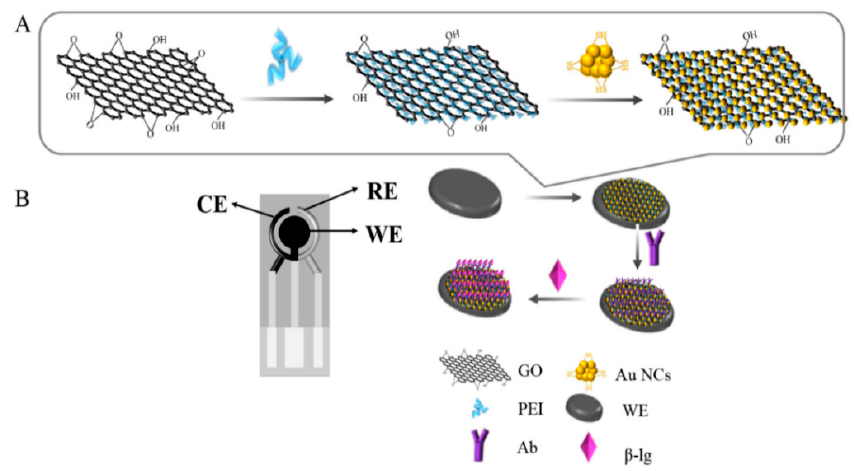
Figure 1. Basic principles of this research strategy: ( A ) assembly process of the composite material obtained by modifying reduced graphene oxide (rGO) with polyethyleneimine (PEI) and gold nanoclusters (AuNCs) (PEI-rGO-AuNCs); ( B ) assembly steps of electrochemical sensors. CE = counter electrode, RE = counter electrode, and WE = working electrode.